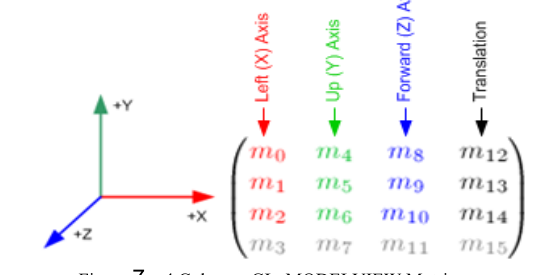
Figure 7 – 4 Columns GL_MODELVIEW